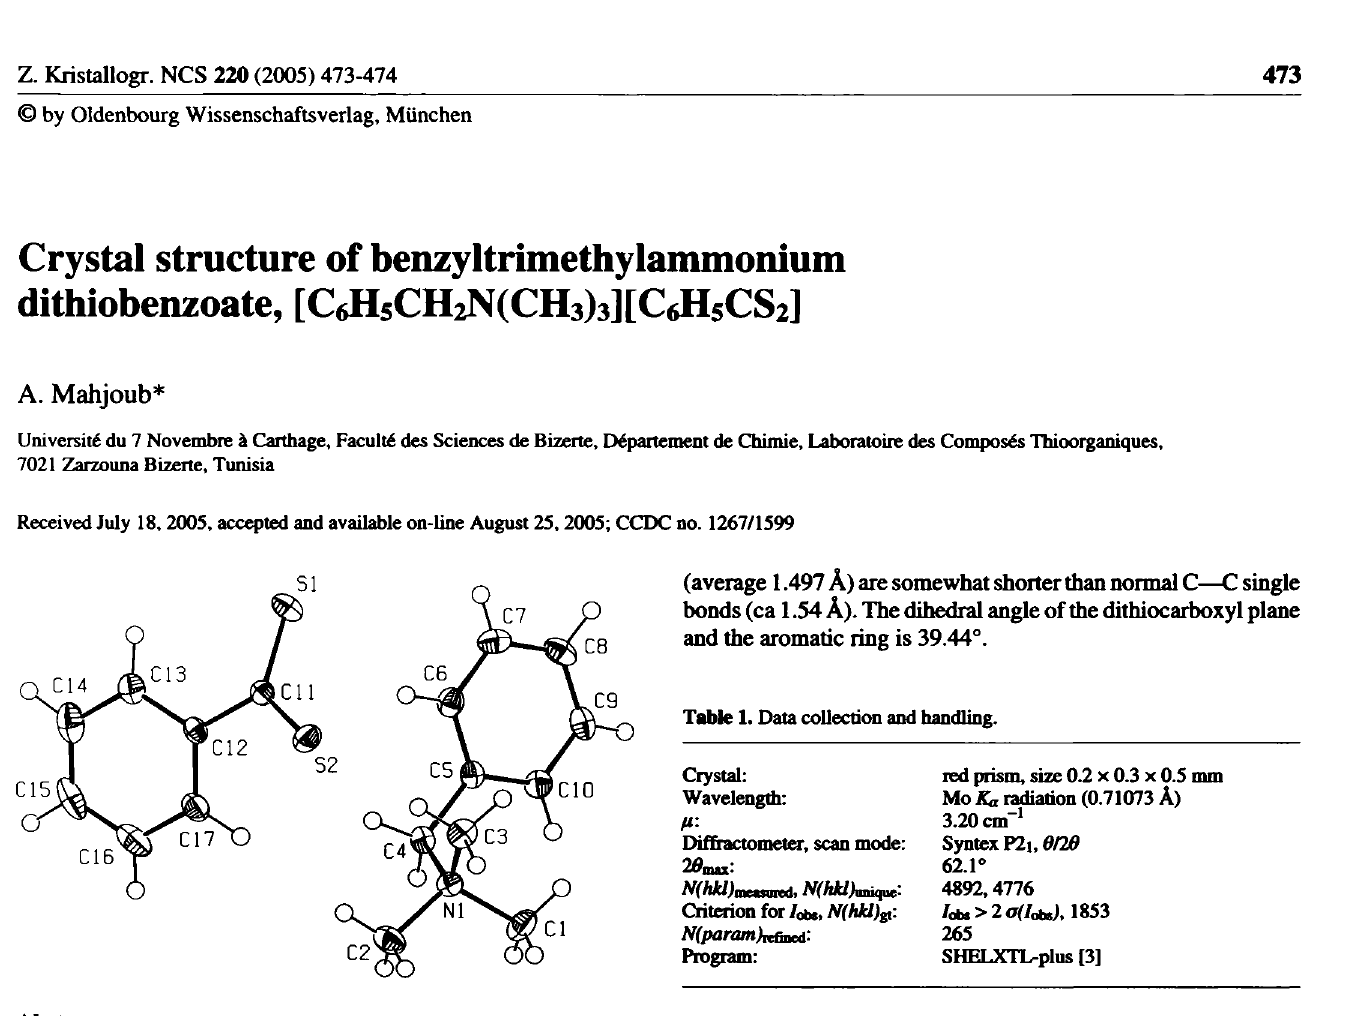
Table 2. Atomic coordinates and displacement parameters (in A 2 ).